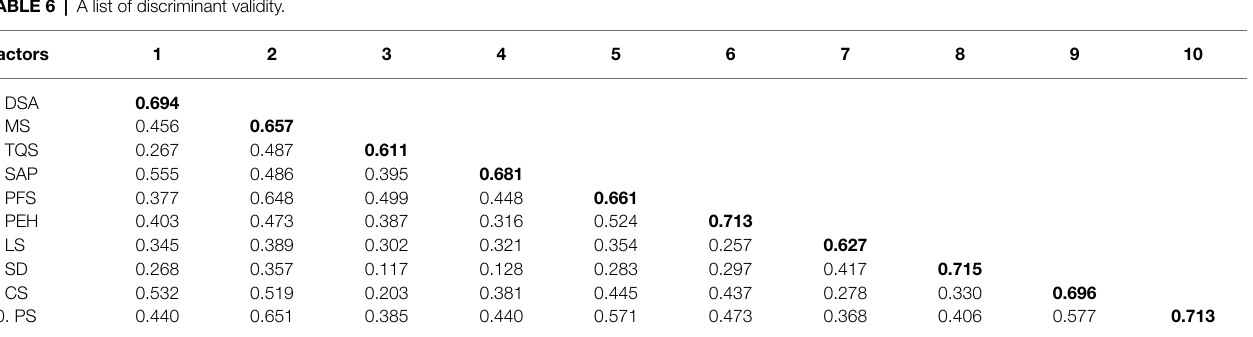
TABLE 6 | A list of discriminant